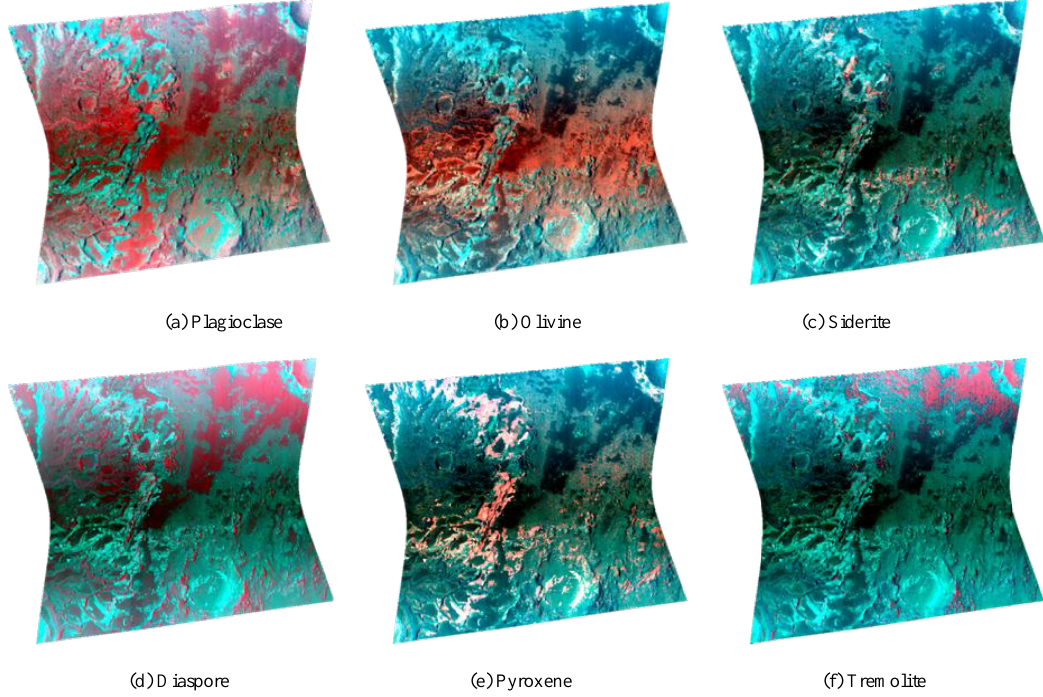
Figure 2. Abundance maps of minerals(R: Abundance map, G: 1.506μm, B: 1.080μm). The minerals are in red